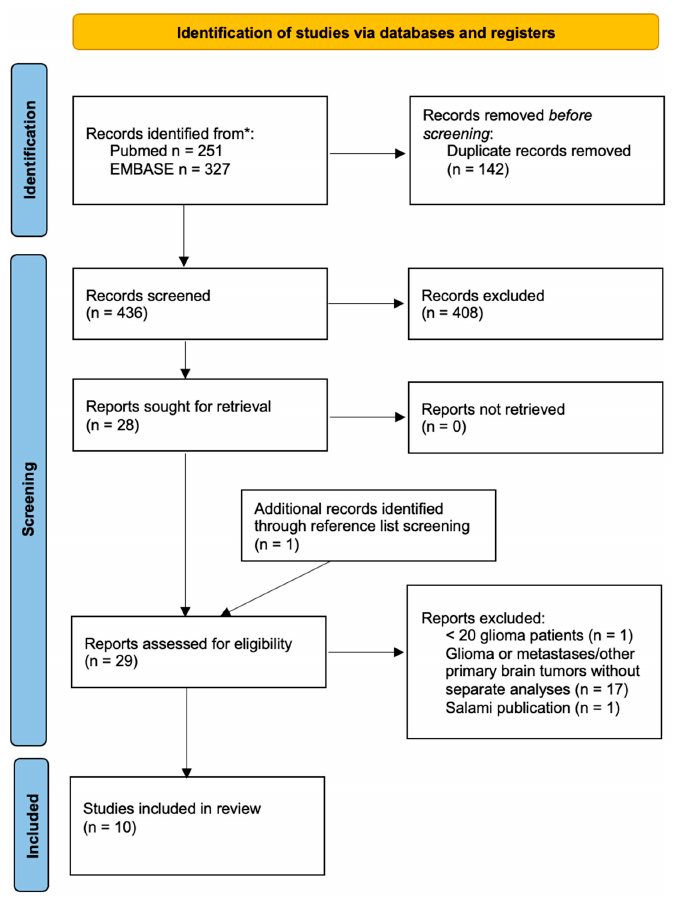
Figure 1. Summary of the article selection process. *Search performed up to 15 th December